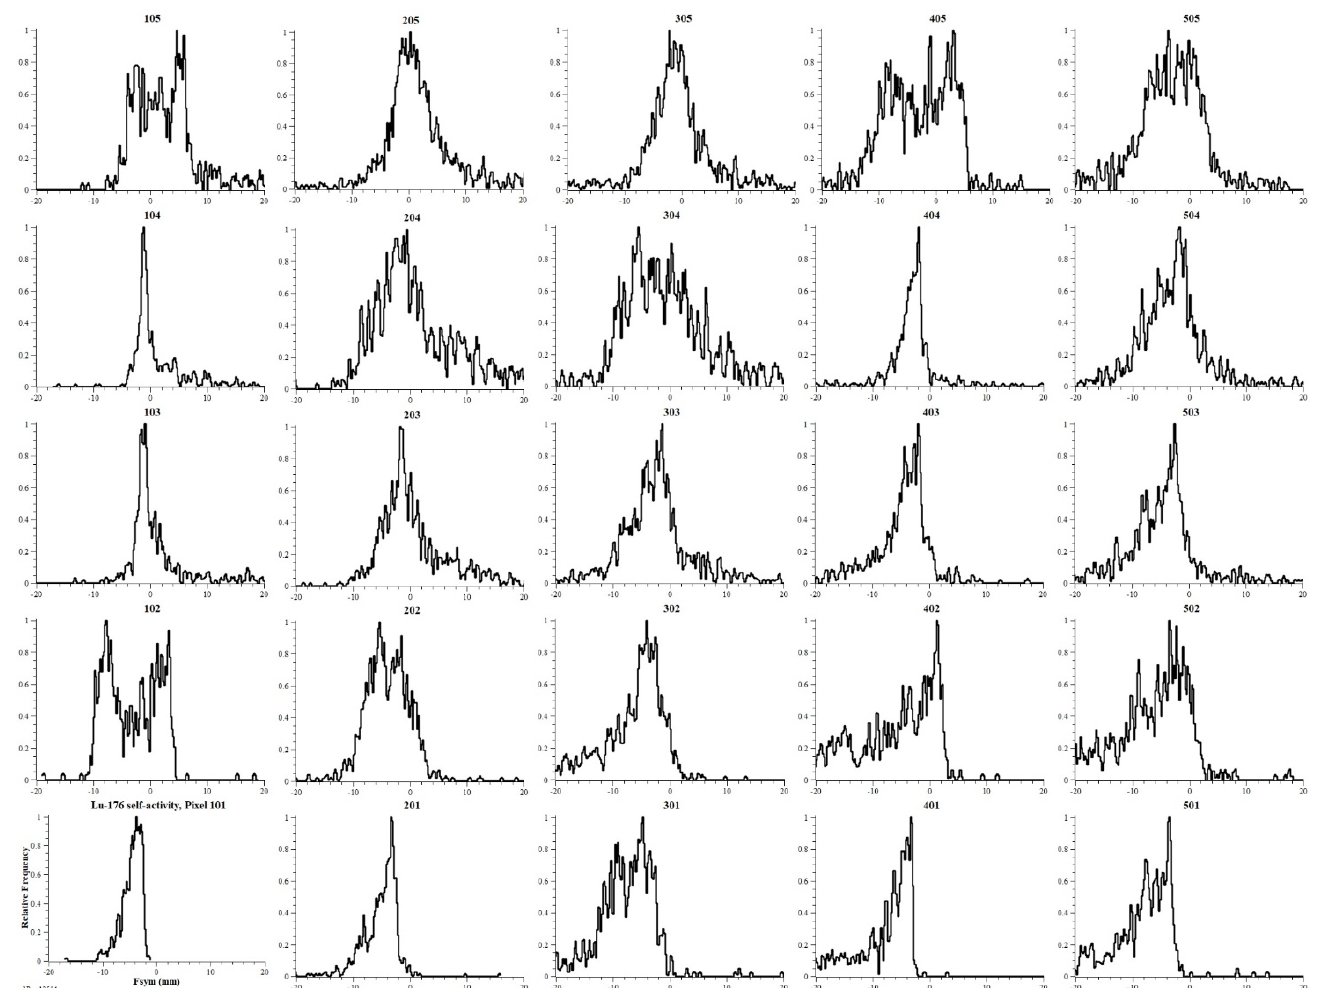
Figure A11. Fsym spectra per pixel for the first quarter of crystal-array from Lu-176 self-activity data-taking. The first quarter includes the pixels with RR ≤ 5 and CC ≤ 5. The common axes and plot descriptions are reported only once in the bottom-left frame. The spectra, obtained by building histograms from single-events Fsym values with 0.2 mm binning, have undergone smoothing for denoising data. The frequency values were normalized, pixel by pixel, to the respective maximum value.